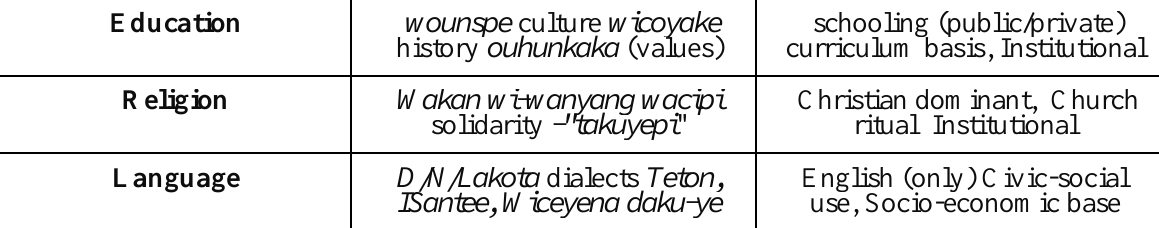
Table 1E. Cultural Social Sphere (isolated)